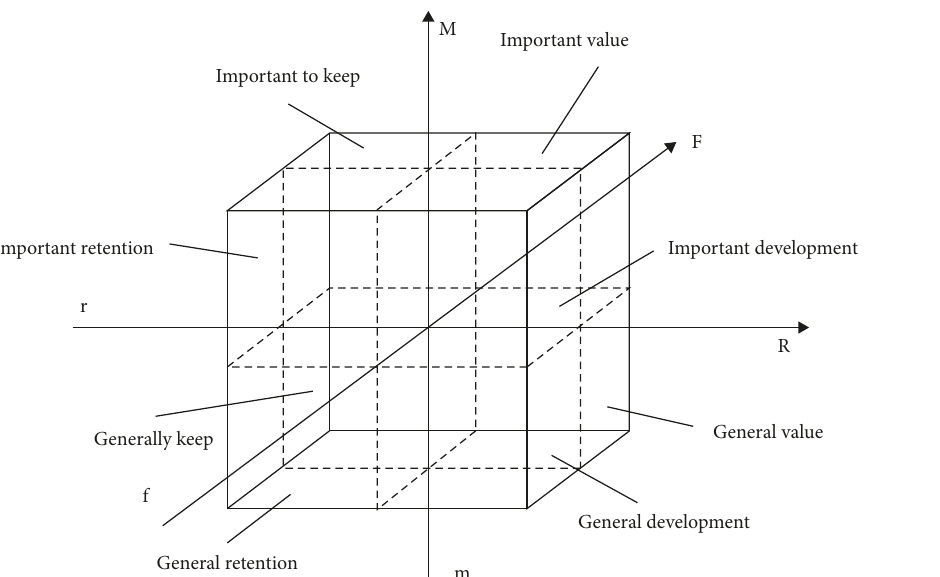
Figure 4: Clustering segmentation points.